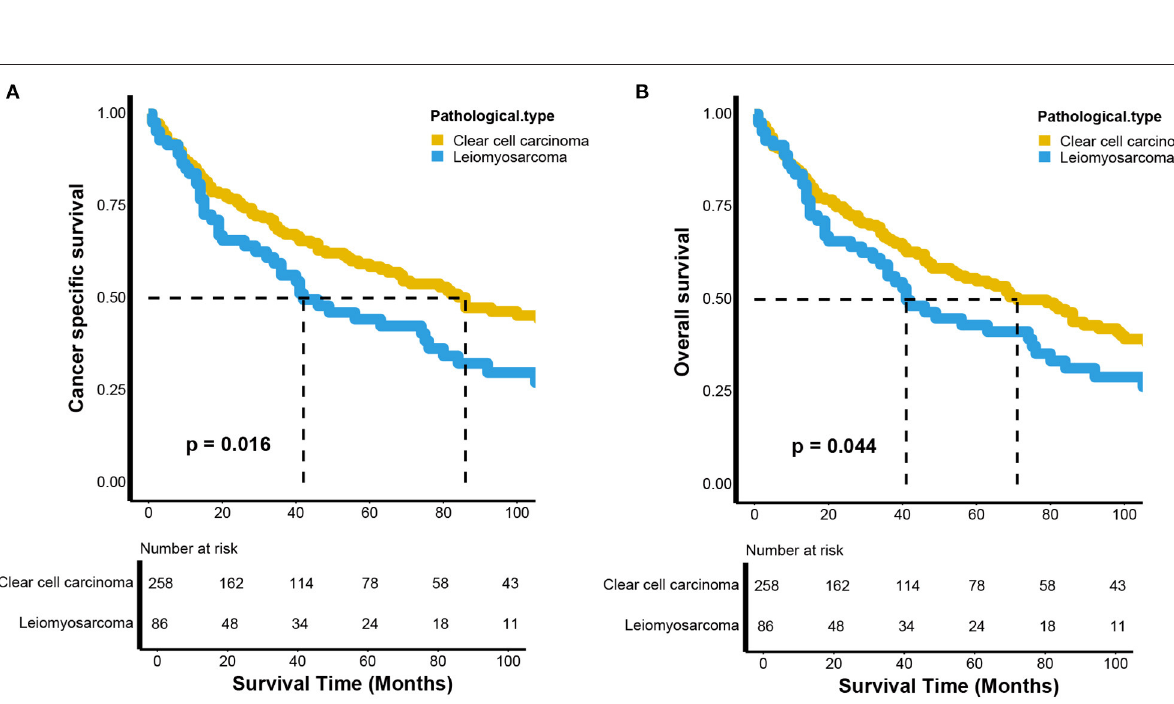
Frontiers in Surgery |